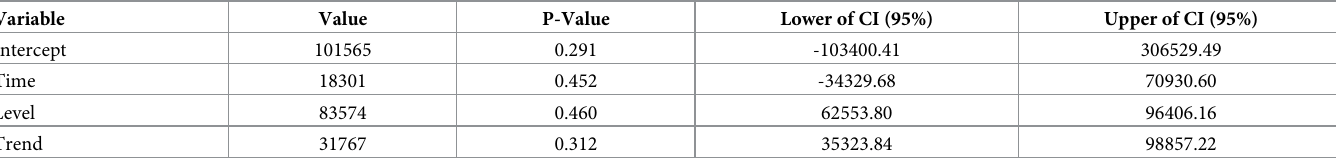
Table 2. The coefficients of the segmented regression model after return to normal conditions in hospitals.